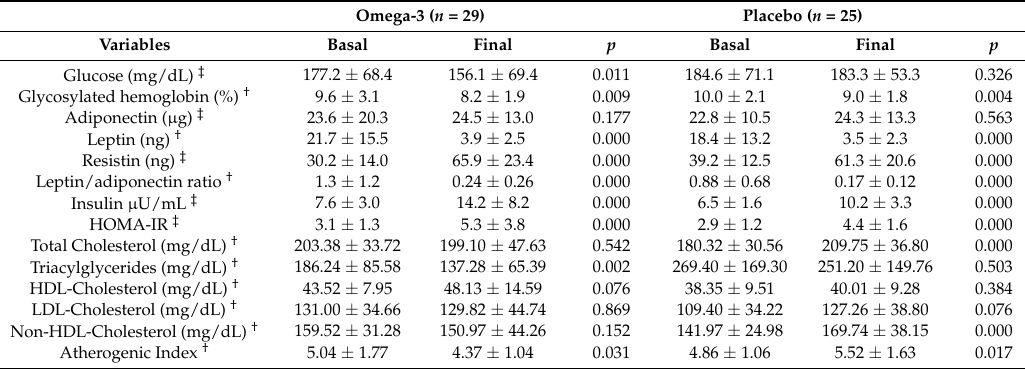
Table 2. Biochemical measurements.